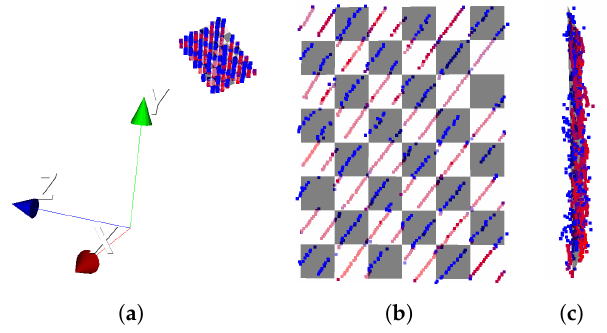
Figure 15. Estimated corners of chessboard. ( a ) The fitted chessboard model of the point cloud in the real Velobug LiDAR coordinate system; ( b ) The front view of the zoom checkerboard; ( c ) The side view of the zoom